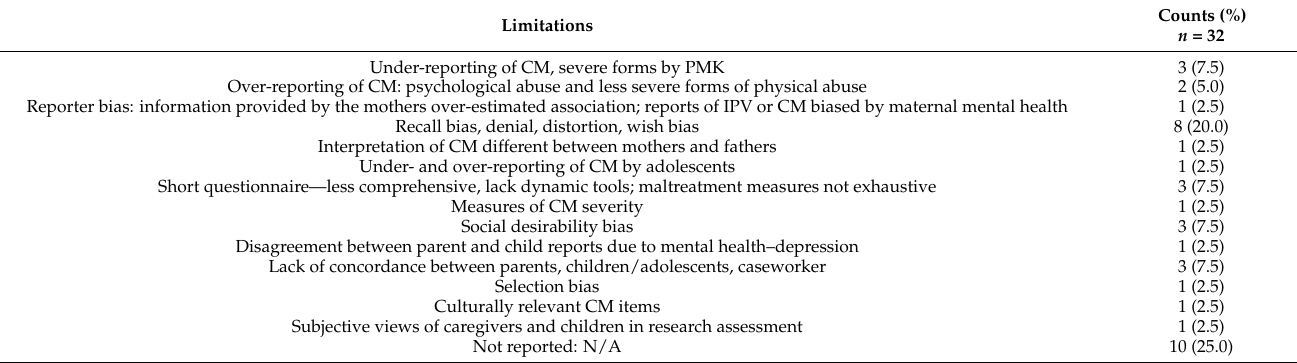
Table 7. Limitations associated with using PMKs to report on child maltreatment experiences 1